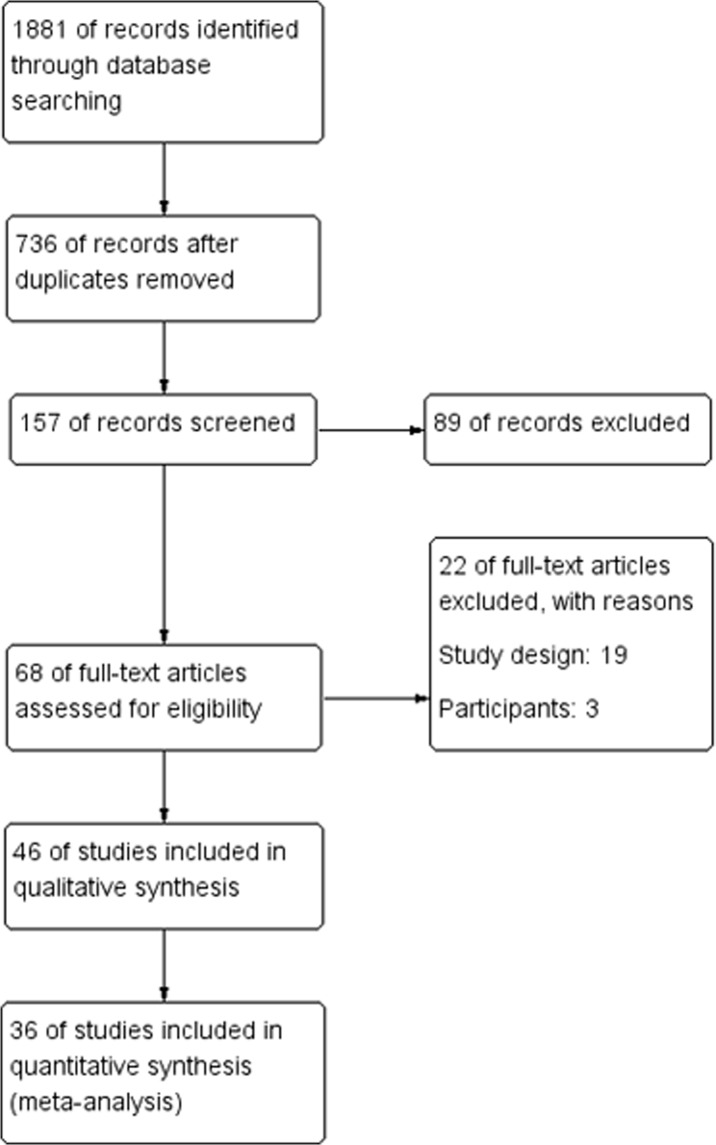
Flow chart of study selection.